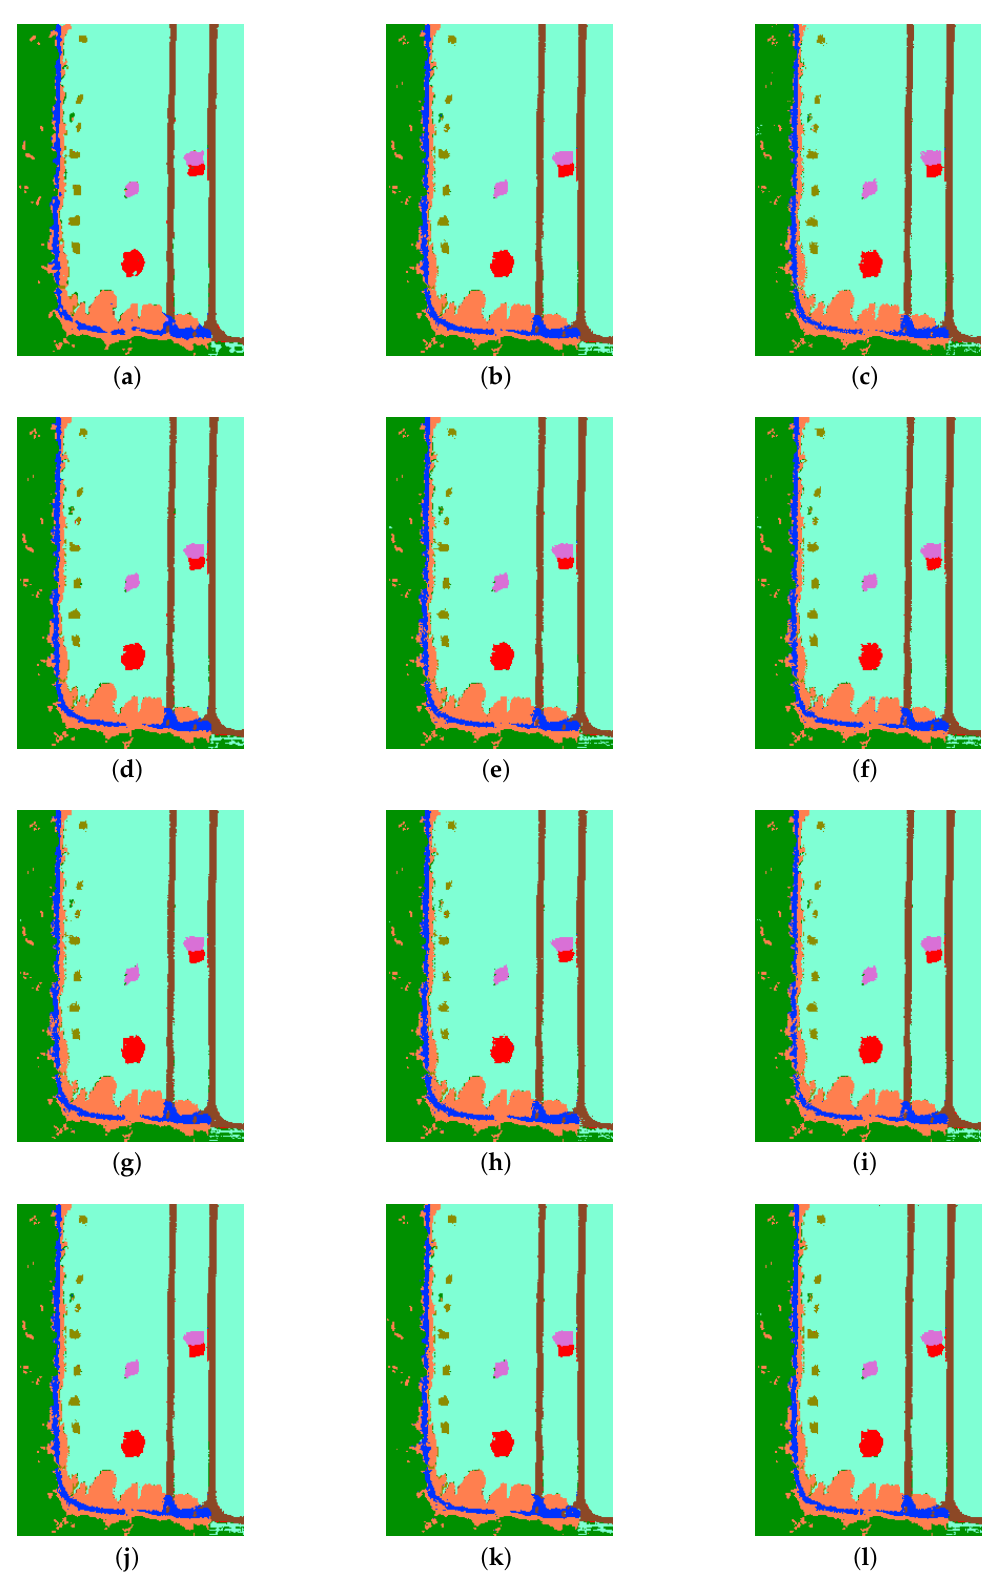
Figure 13. Classification results: ( a ) 2DCNN; ( b ) GAB-2DCNN; ( c ) MAM-2DCNN; ( d ) 3DCNN; ( e ) GAB-3DCNN; ( f ) CBAM-3DCNN; ( g ) SE-3DCNN; ( h ) DA-3DCNN; ( i ) ECA-3DCNN; ( j ) DECA- 3DCNN; ( k ) ECA-CBAM-3DCNN; ( l )